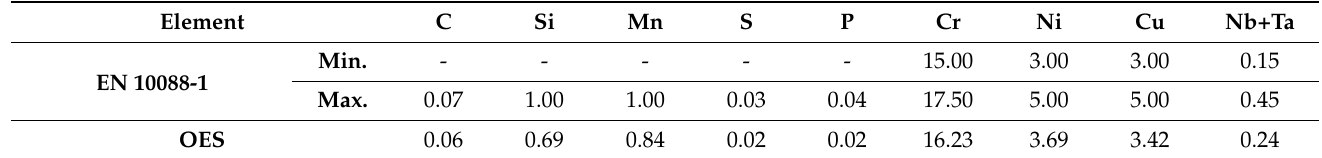
Table 2. The chemical composition of 17-4 PH stainless steel used for welding. Element